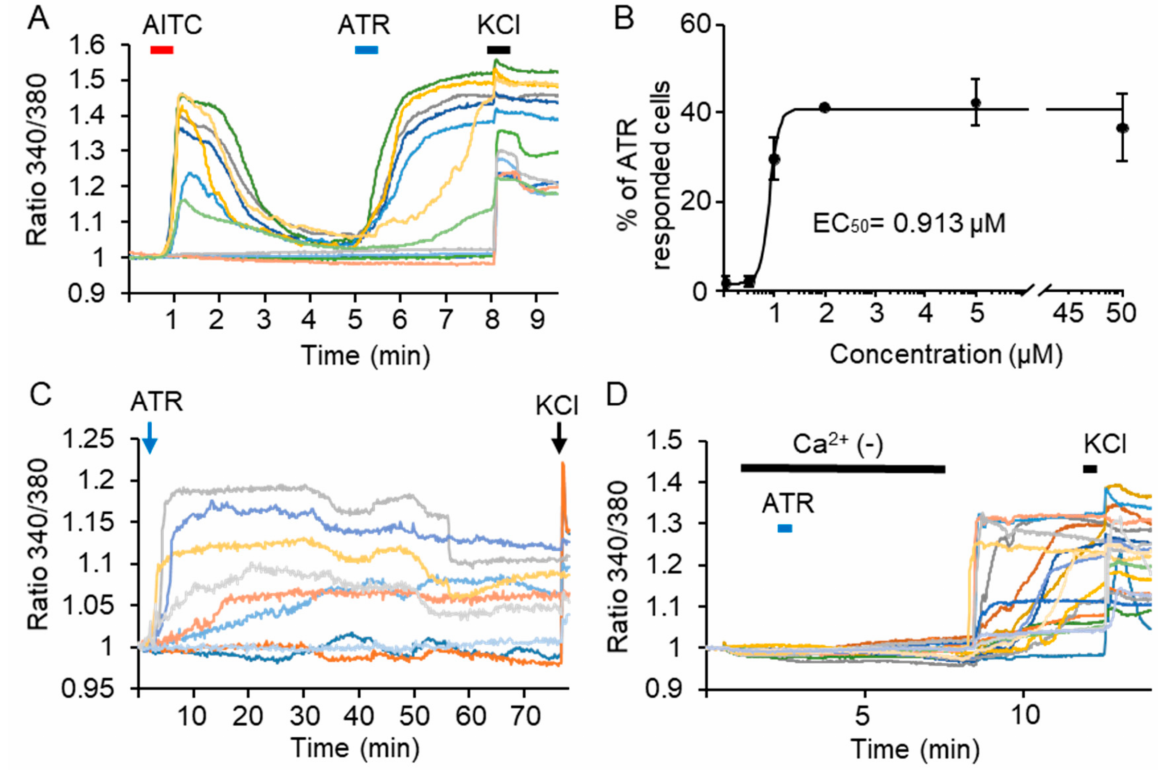
Figure 3. Bath application of atractylodin induced a long-lasting calcium response in the dorsal root ganglion neurons. ( A – D ) Calcium imaging analysis with rat primary cultured dorsal root ganglion neurons. Ratiometric measurement of Fura-2AM was performed to analyze cytosolic Ca 2+ levels. Calcium response from different cells is shown in different colors. The calcium responses induced by bath application of 100 µ M AITC followed by 5 µ M ATR ( A ), dose–response curve of ATR ( n = 3 in each group) ( B ), the long-lasting effect of ATR ( C ), and the effect of the calcium-free solution on ATR-induced calcium response ( D ). AITC: allyl isothiocyanate; ATR: